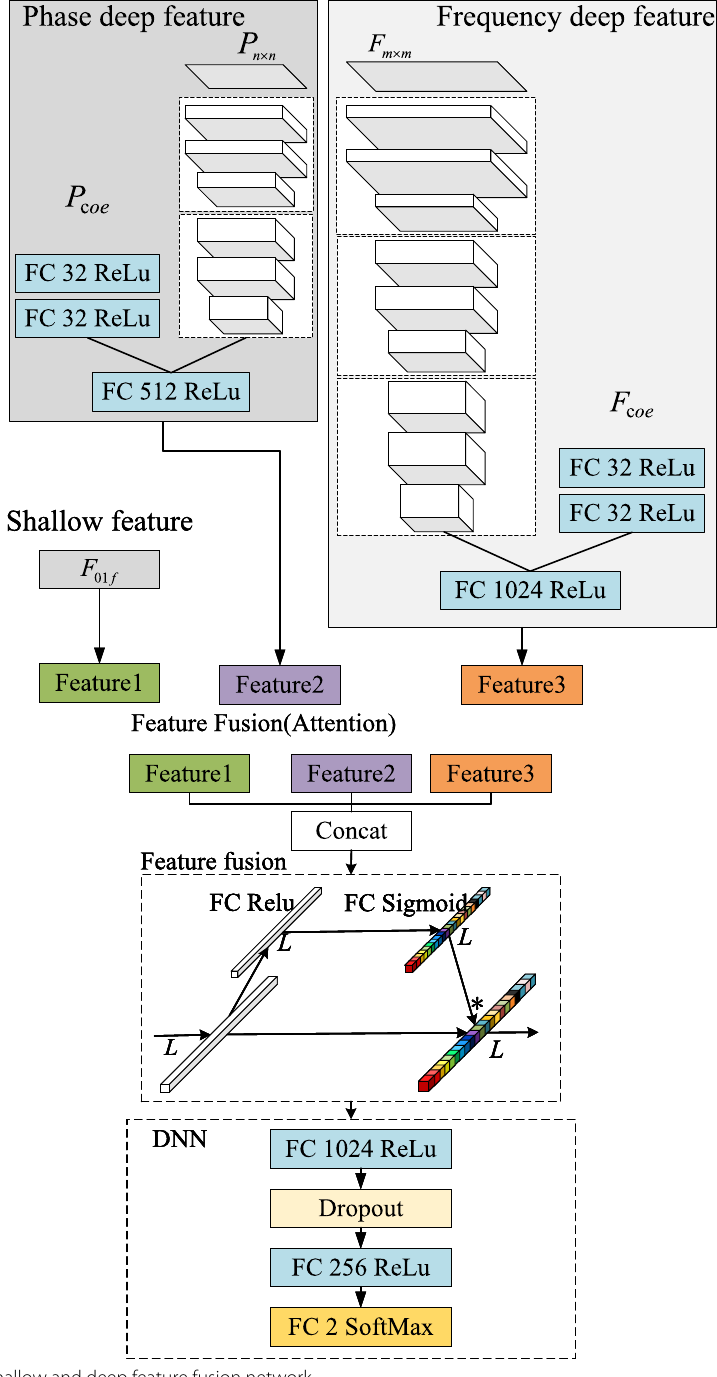
Fig. 3 Shallow and deep feature fusion